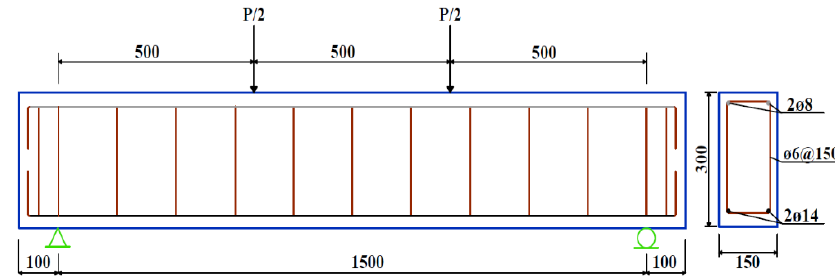
Figure 12. Detailed Geometry of Dong et al. Control Specimen (FB30-1) [7].